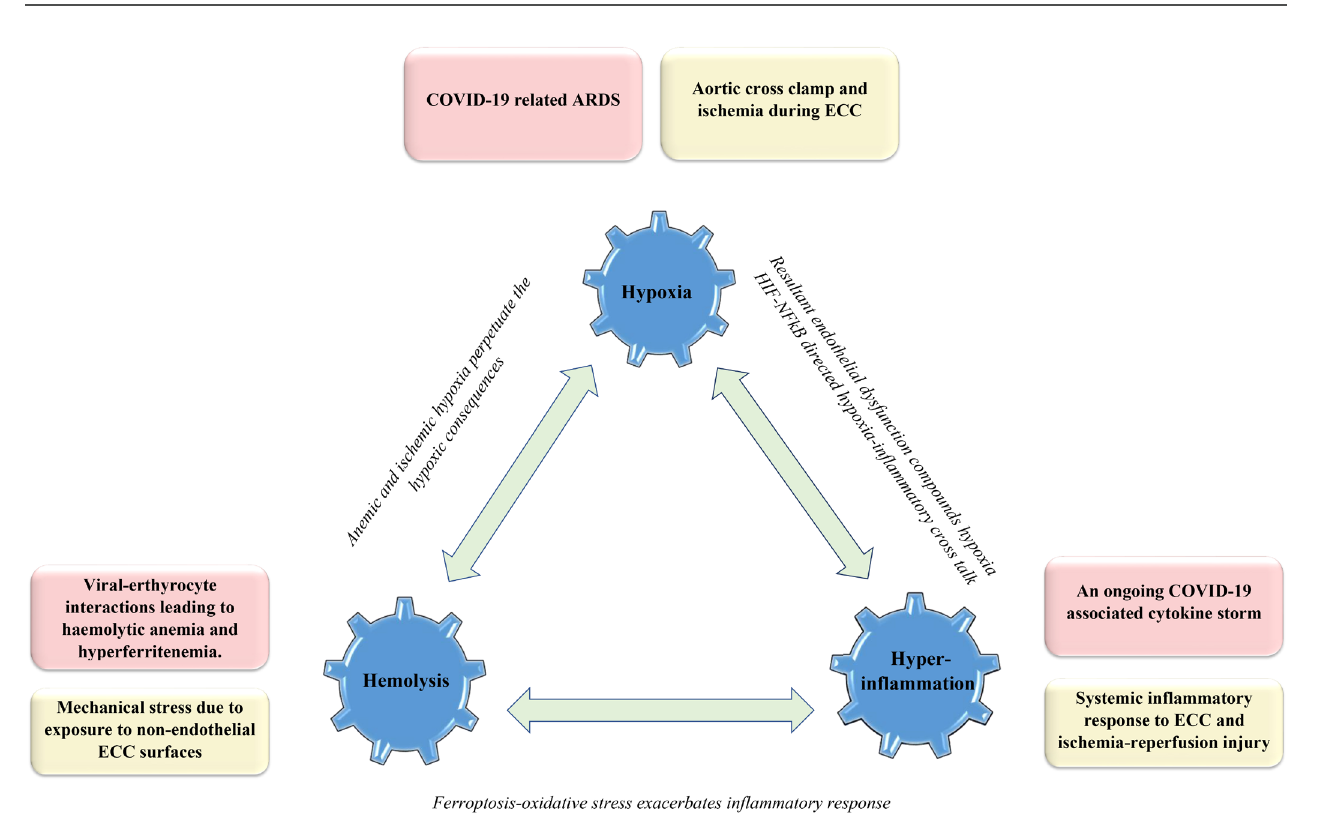
Fig. 1 - Illustration of the 3H (Hypoxia-Hemolysis-Hyperinflammation) trimodal insult owing to a double hit by COVID-19 (represented in pink) and CPB (represented in yellow). ARDS=acute respiratory distress syndrome; CPB=cardiopulmonary bypass; HIF=hypoxia-inducible factor; NFκB=nuclear factor-kappa